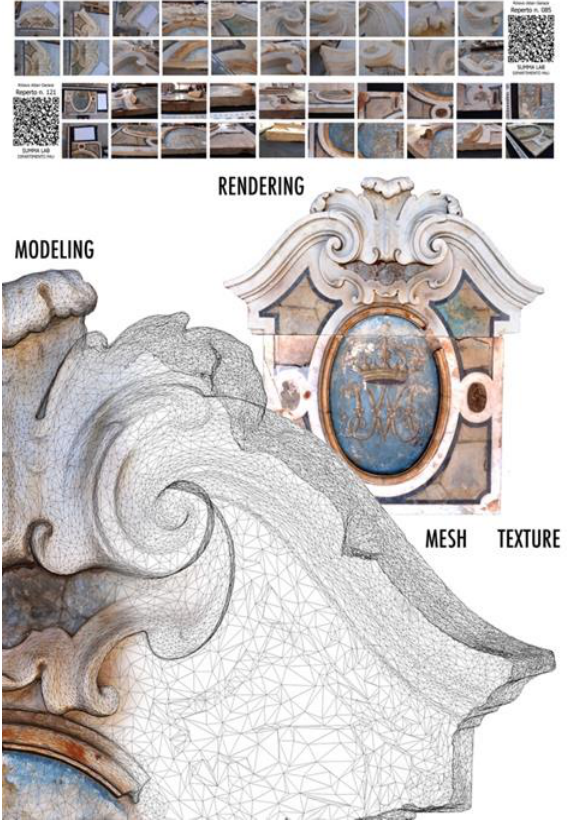
Figure 7. Re-elaboration of the crowning gable end of the altar.